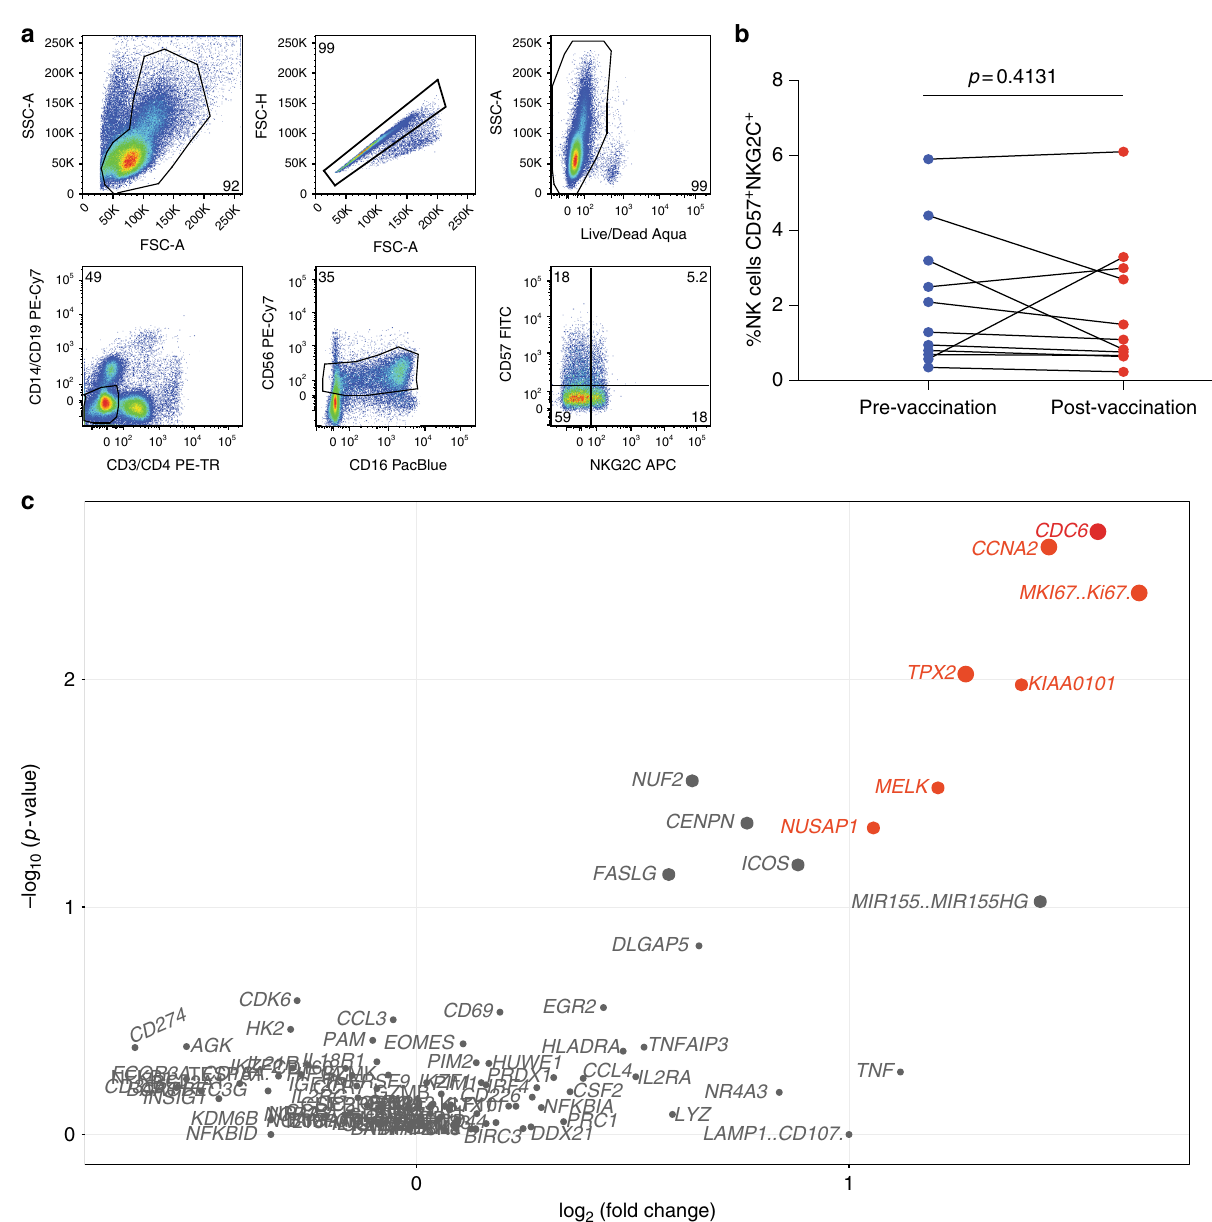
Fig. 8 Cell surface expression of NKG2C and gene expression of CD57 + NKG2C + NK cells in vaccinated individuals. a Flow cytometric gating strategy of sorted CD57 + NKG2C + NK cells. b Graphical analysis of frequency of CD57 + NKG2C + NK cells in vaccinated individual ’ s pre (blue)- and post (red) vaccination. Wilcoxon matched-pair sign-rank test was used to determine signi fi cance between frequencies of each group. c Volcano plot displaying upregulated (red) and stably expressed (gray) pre-selected genes, involved in NK cell-mediated responses to MVA vaccination. Size of each data point is calculated as − log 10 ( p -value) × log 2 (FC), p -value cutoff p < 0.05, fold change cutoff > 2 or <1/2. Transcriptional analysis from 11 vaccinated individuals